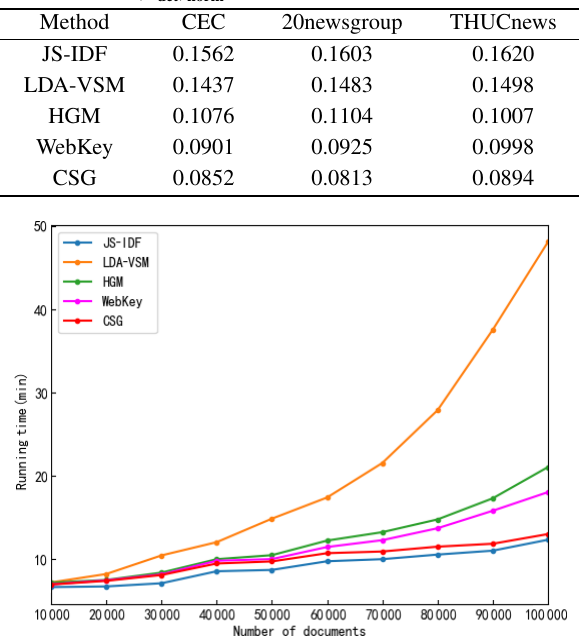
Table 2 ( C det ) norm of all methods on three datasets.